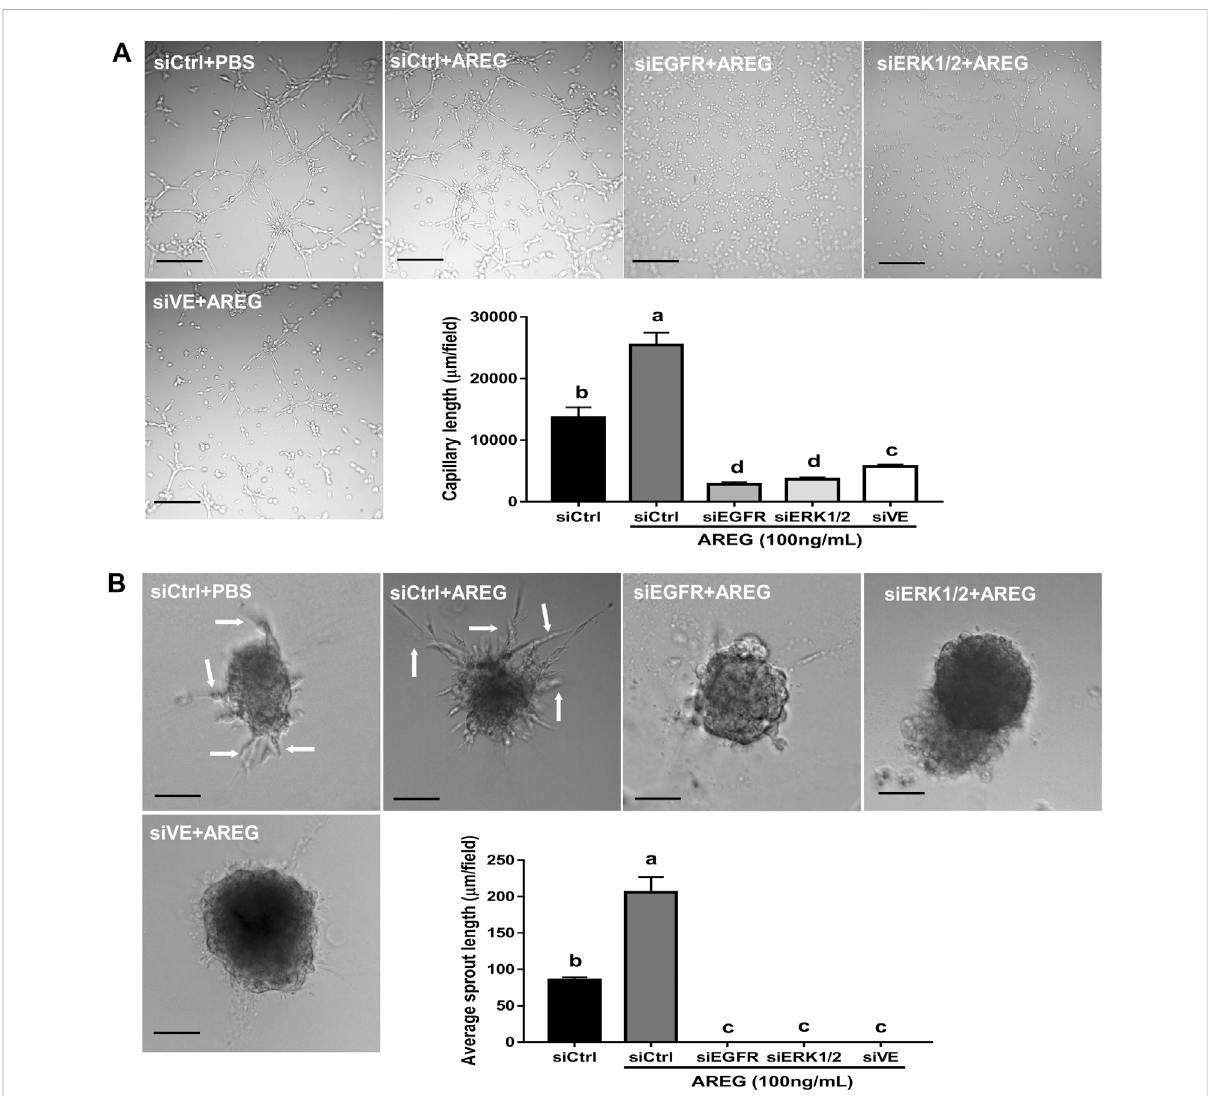
FIGURE 7 Effects of targeted depletion of EGFR, ERK1/2 and VE-cadherin on AREG-induced microvasculature-like formation in SVOG cells. Cells were transfected with 25 nM siControl, siEGFR, siERK1/2 or siVE-cadherin for 24 h and treated for further 24 h with or without AREG (100 ng/ml). Finally, the cells were transferred to Matrigel for an additional 5 h (for capillary-like formation) (A) or 24 h (for sprout-like formation) (B) . Scale bars of the capillary-like formation and sprout-like formation represent 100 µm and 50 μ m, respectively. The lengths of the capillaries and sprouts were quanti fi ed by ImageJ. Values labeled with different letters are signi fi cantly different ( p < 0.05), n =